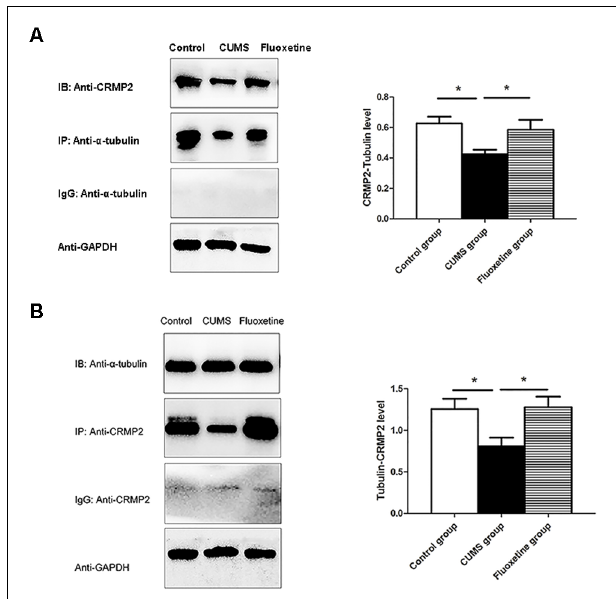
FIGURE 5 | Effect of CUMS and fluoxetine treatment on the interaction between CRMP2 and α -tubulin (A,B) . * P < 0.05.